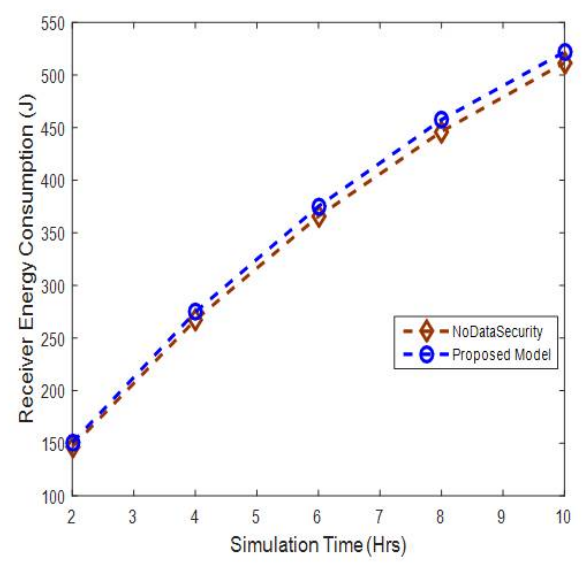
Figure 9. Receiver energy consumption versus simulation time.